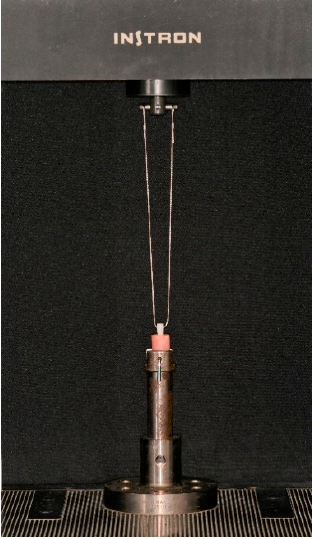
Figure 2. Metal cable connecting the zirconium oxide coping and the universal testing machine.